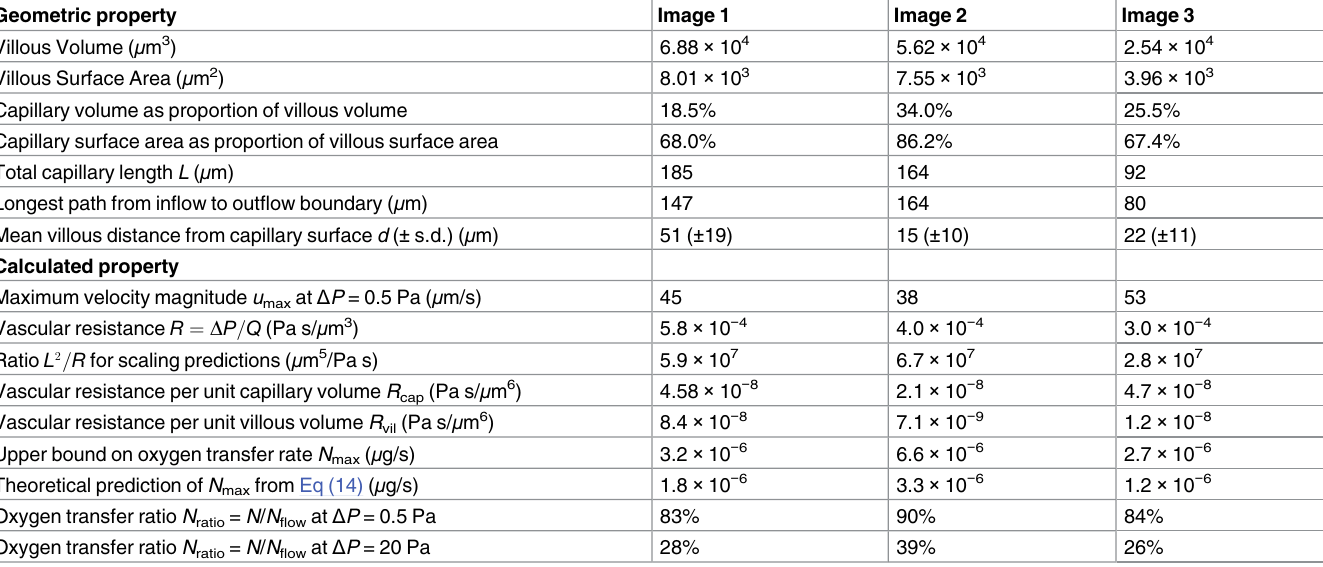
Table 3. Geometric and calculated properties of the three 3D images used in the paper.